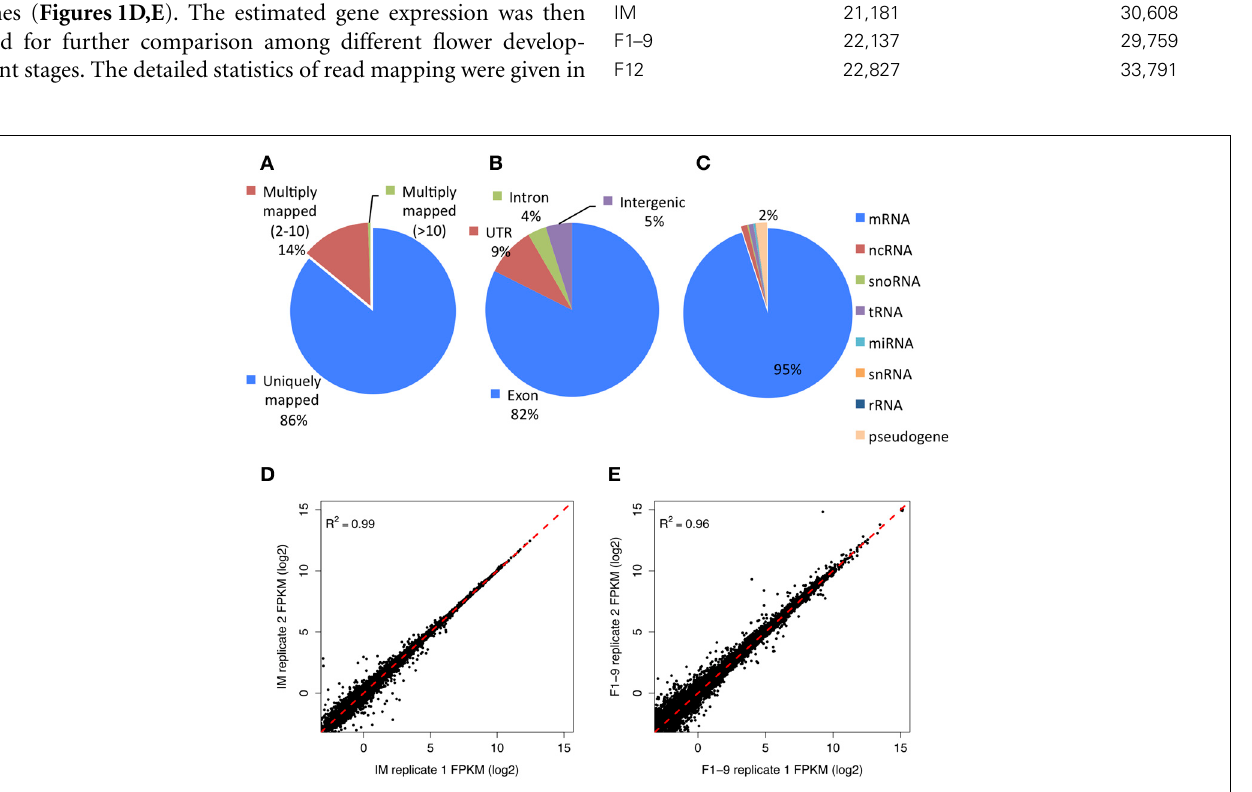
(percentage: mRNA 0.95; ncRNA 0.01; snoRNA 0.002; tRNA 0.009; miRNA 0.003; snRNA 0.0004; rRNA 0.0005; pesudogene 0.021). (D) Gene expression comparison between the two technical replicates for the inflorescent meristem (IM) stage. (E) Same comparison for flower development stage 1 to stage 9